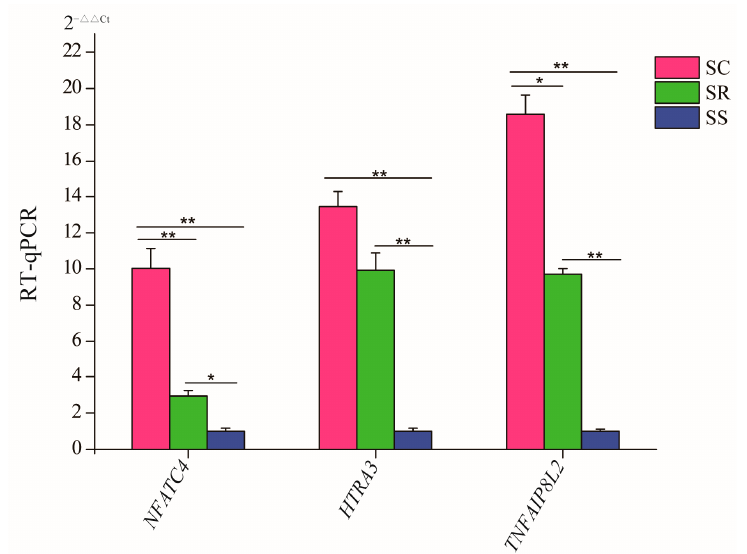
Figure 8. Expression of several potential target mRNAs in SC, SR, and SS groups. The results are